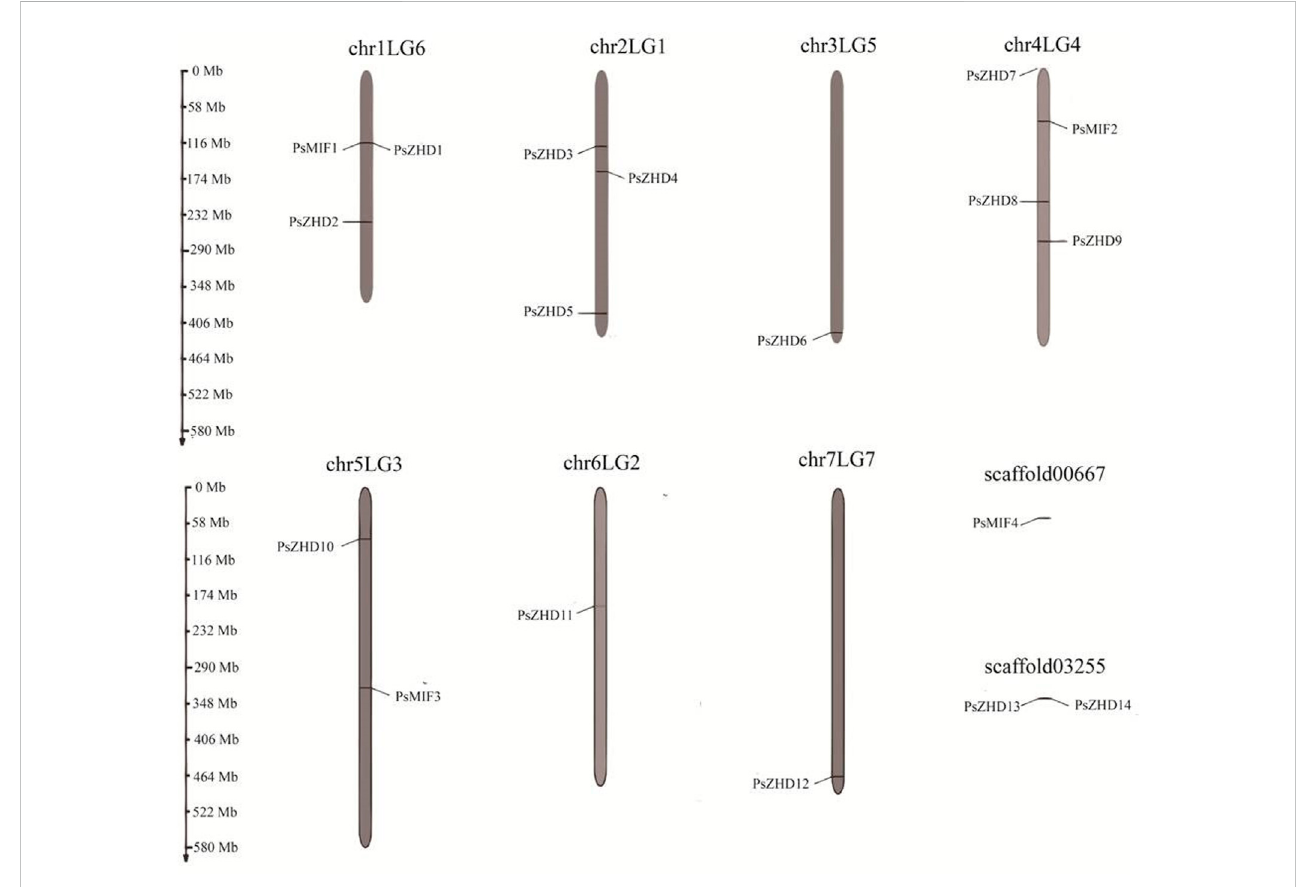
FIGURE 2 Physical distribution of PsZF-HD genes among seven chromosomes and